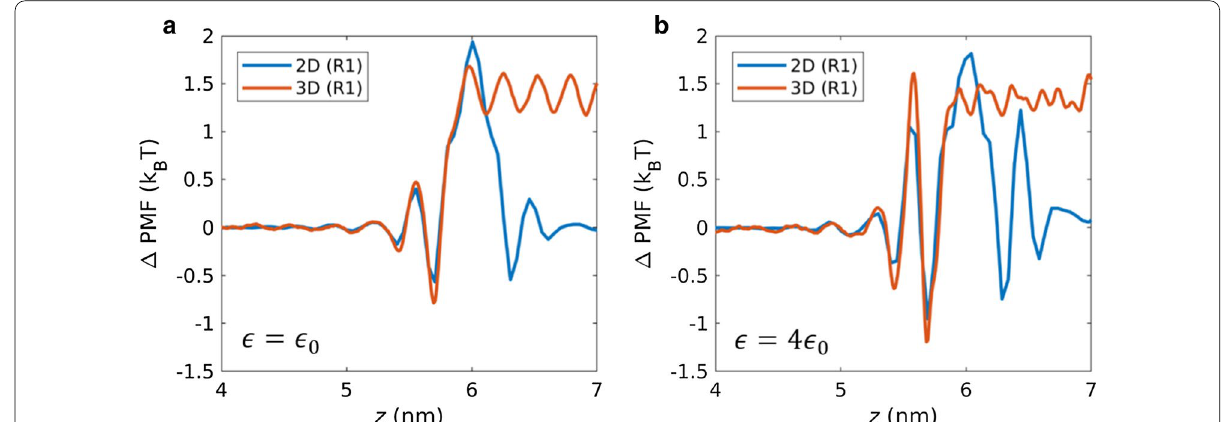
Fig. 6 PMF profiles along the pore axial direction for a a moderate interaction strength ( ǫ 0 ) and b high interaction strength ( 4 ǫ 0